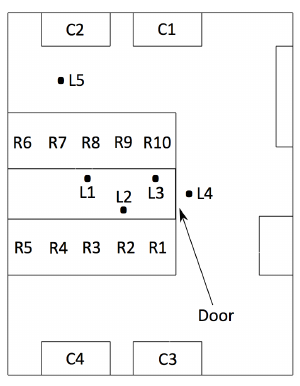
Figure 2. Labeled CRAC units, server racks and measurement